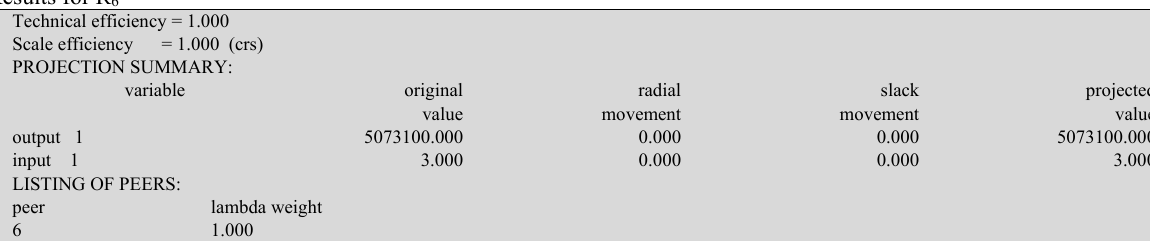
Results for R 6 Technical efficiency = 1.000